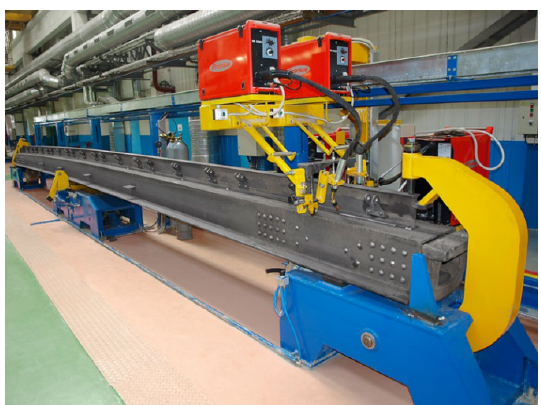
Figure 5. Diagram of the stress-strain state of the centre sill